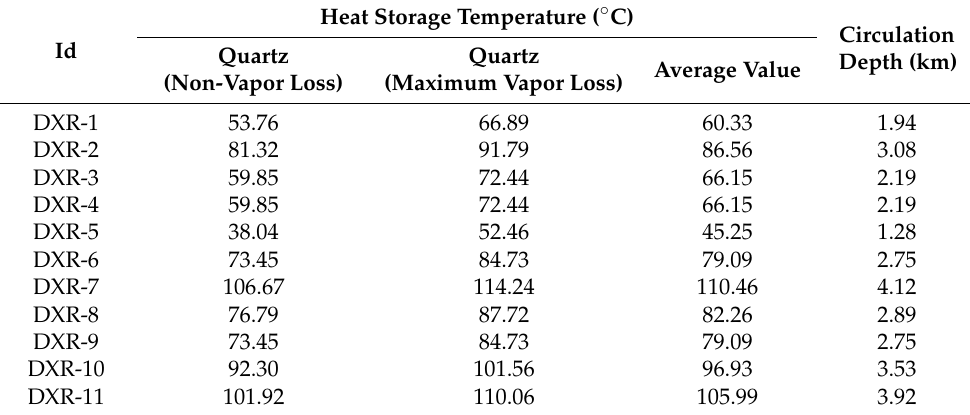
Table 7. Geothermal fluid circulation depth table of calculation